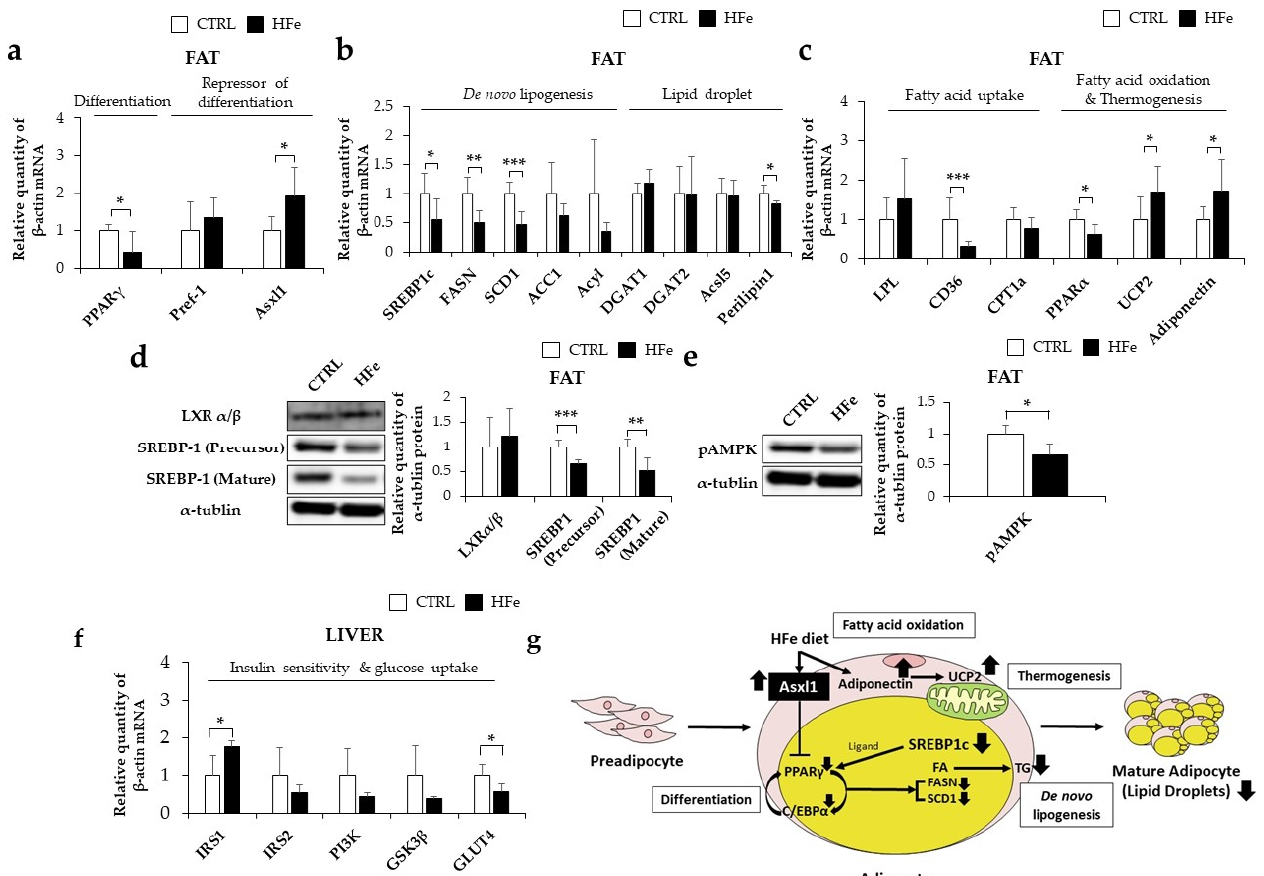
Figure 5. Ann excessive iron diet affected FA biosynthesis and differentiation of adipocytes more than FA β -oxidation. ( a ) Amount of mRNA level in differentiation of adipocyte ( b ) de novo lipogenesis, lipid droplet FA uptake, and FA oxidation ( c ) and in mesenteric fat as measured by RT-PCR. Effects of HFe on protein levels in mesenteric fat related to ( d ) FA synthesis and ( e ) FA oxidation. ( f ) Hepatic mRNA levels of insulin sensitivity and glucose uptake. ( g ) Proposed schematic mechanism of the alteration on lipid metabolism by HFe. Data are expressed as means ± SE; Student’s t test was used to test differences between means. * p < 0.05, ** p < 0.01, *** p < 0.001.